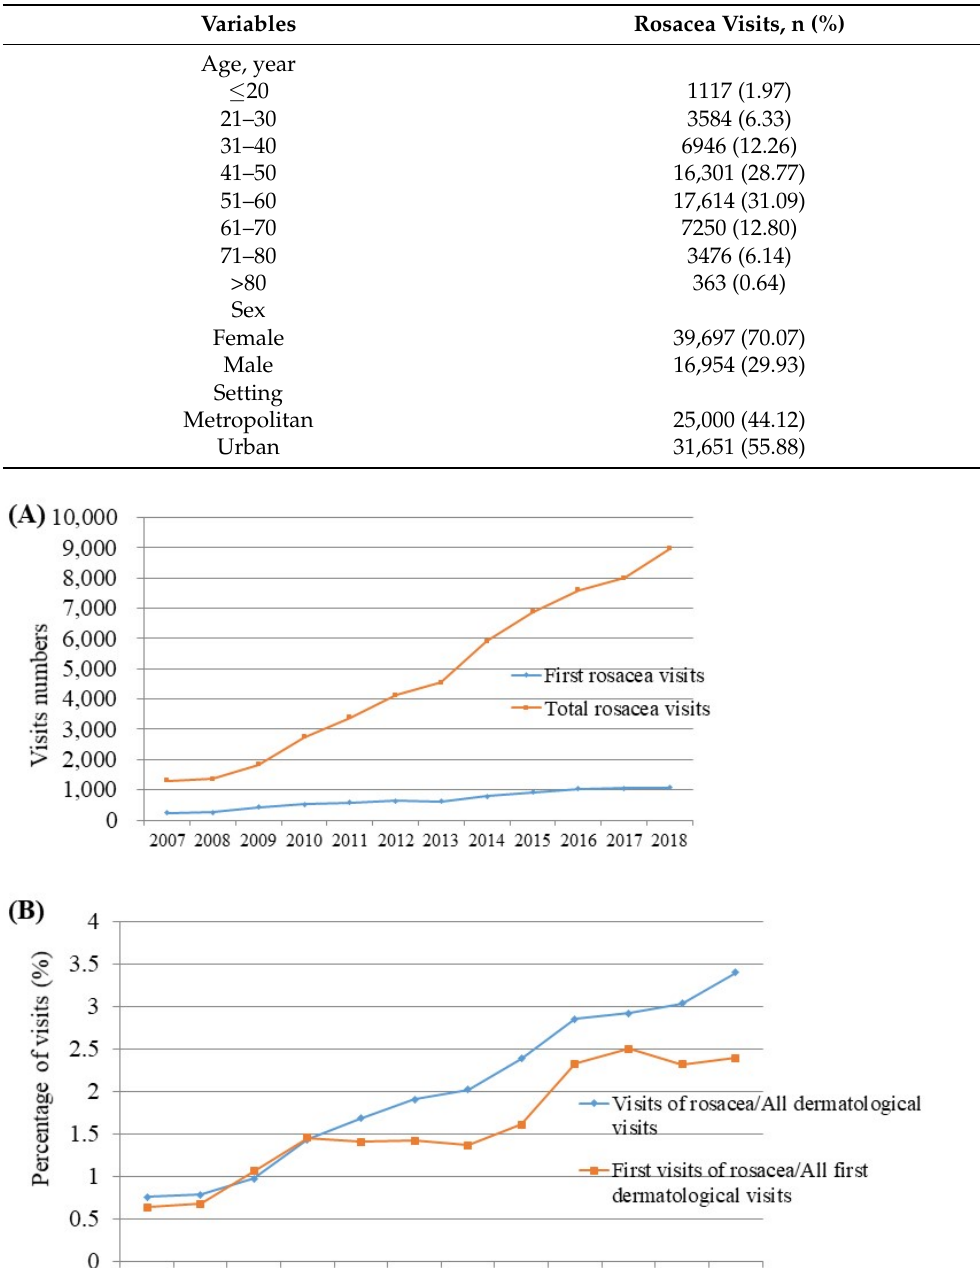
Table 1. Demographic characteristics of rosacea visits.